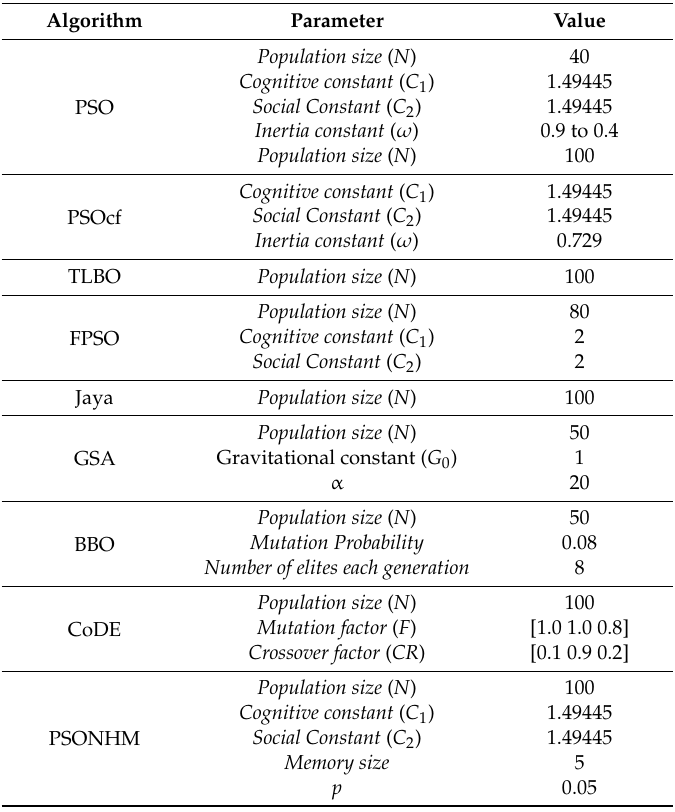
Table 1. Default parameters settings.